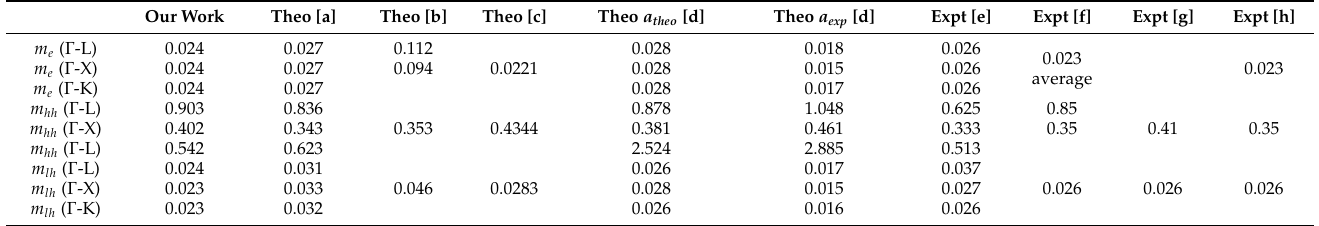
Table 4. Calculated effective masses for zb-InAs (in units of the free electron-mass, m 0 ): m e indicates an electron effective mass at the bottom of the conduction band; m hh , and m lh represent the heavy and light hole effective masses, respectively. Theo: theory, expt: